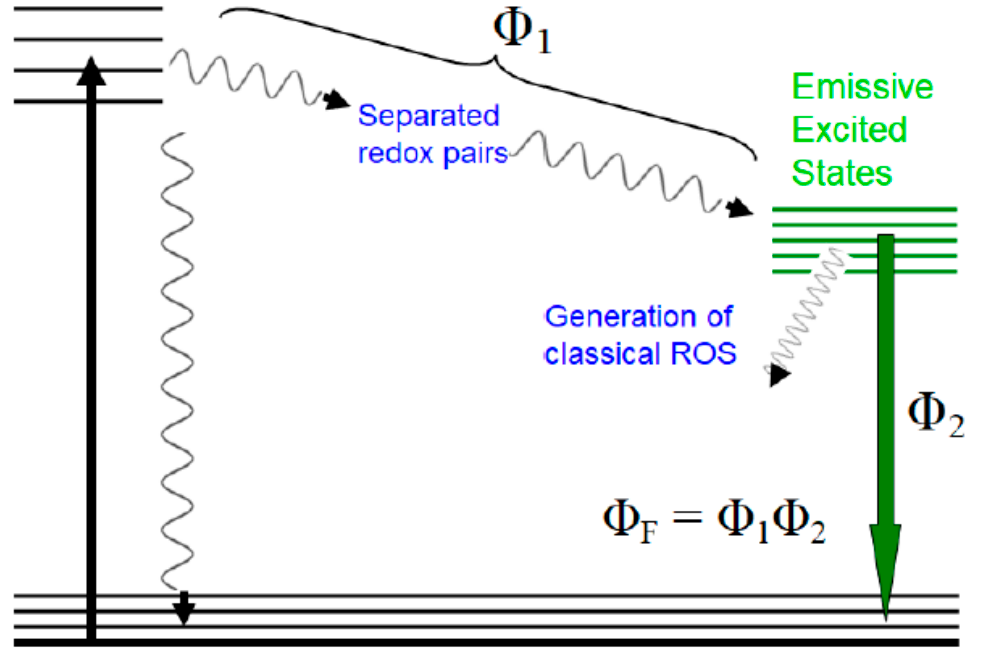
Figure 8. A state energy diagram on the photoexcited states and processes of CDots, highlighting the two sets of highly reactive species: the separated redox pairs from the initial charge transfers and separation and the generation of classical ROS as a part of the nonradiative deactivation of the emissive excited states. Φ F denotes observed fluorescence quantum yields (reprinted with permission from [40]. Copyright 2020 Elsevier).